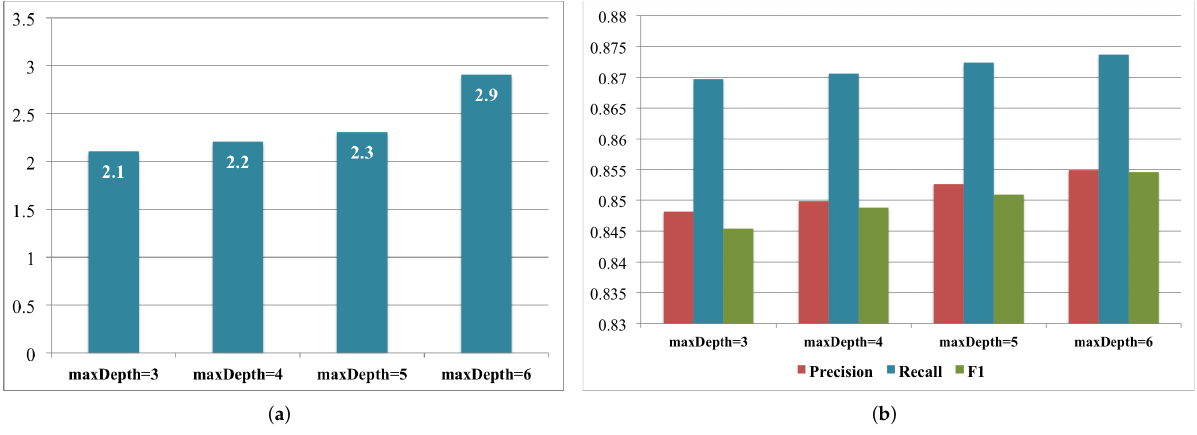
Figure 10. Training time and accuracy of the detection models. ( a ) Training time; ( b )